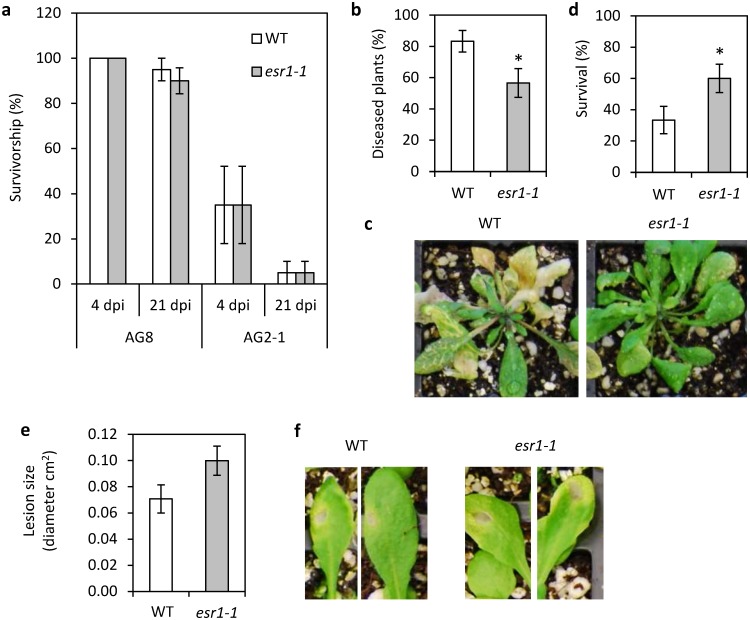

esr1-1 exhibits increased resistance to Fusarium oxysporum.(a) Percentage survivorship of wild-type (WT) and esr1-1 seedlings at 4 and 21 days post inoculation (dpi) with Rhizoctonia solani isolates AG8 and AG2-1. Values are averages ± SE of 4 biological replicates consisting of pools of 5 seedlings. (b-d) Disease phenotypes of F. oxysporum inoculated plants with (b) percentage and (c) representative images of diseased plants 10 days post inoculation. (d) Survival at 21 days post inoculation. Values are averages ± SE (n = 30). (e-f) A. brassicicola induced lesions on (e) WT and esr1-1 leaves 3 days post inoculation with (f) representative images of leaves. Values are averages ± SE of 6 biological replicates consisting of lesion diameters measured from 4 inoculated leaves per plant. Asterisks indicate values that are significantly different (*P<0.05 Student’s t-test) from WT. Similar results were obtained in independent experiments.